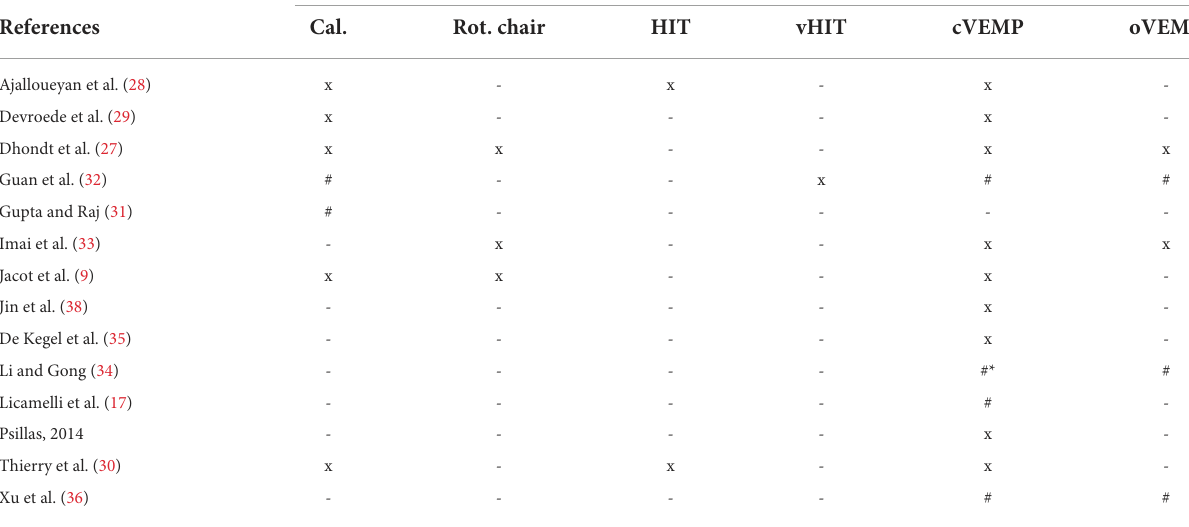
TABLE 4 Post-operative effect of cochlear implantation on vestibular tests on implanted side per tested